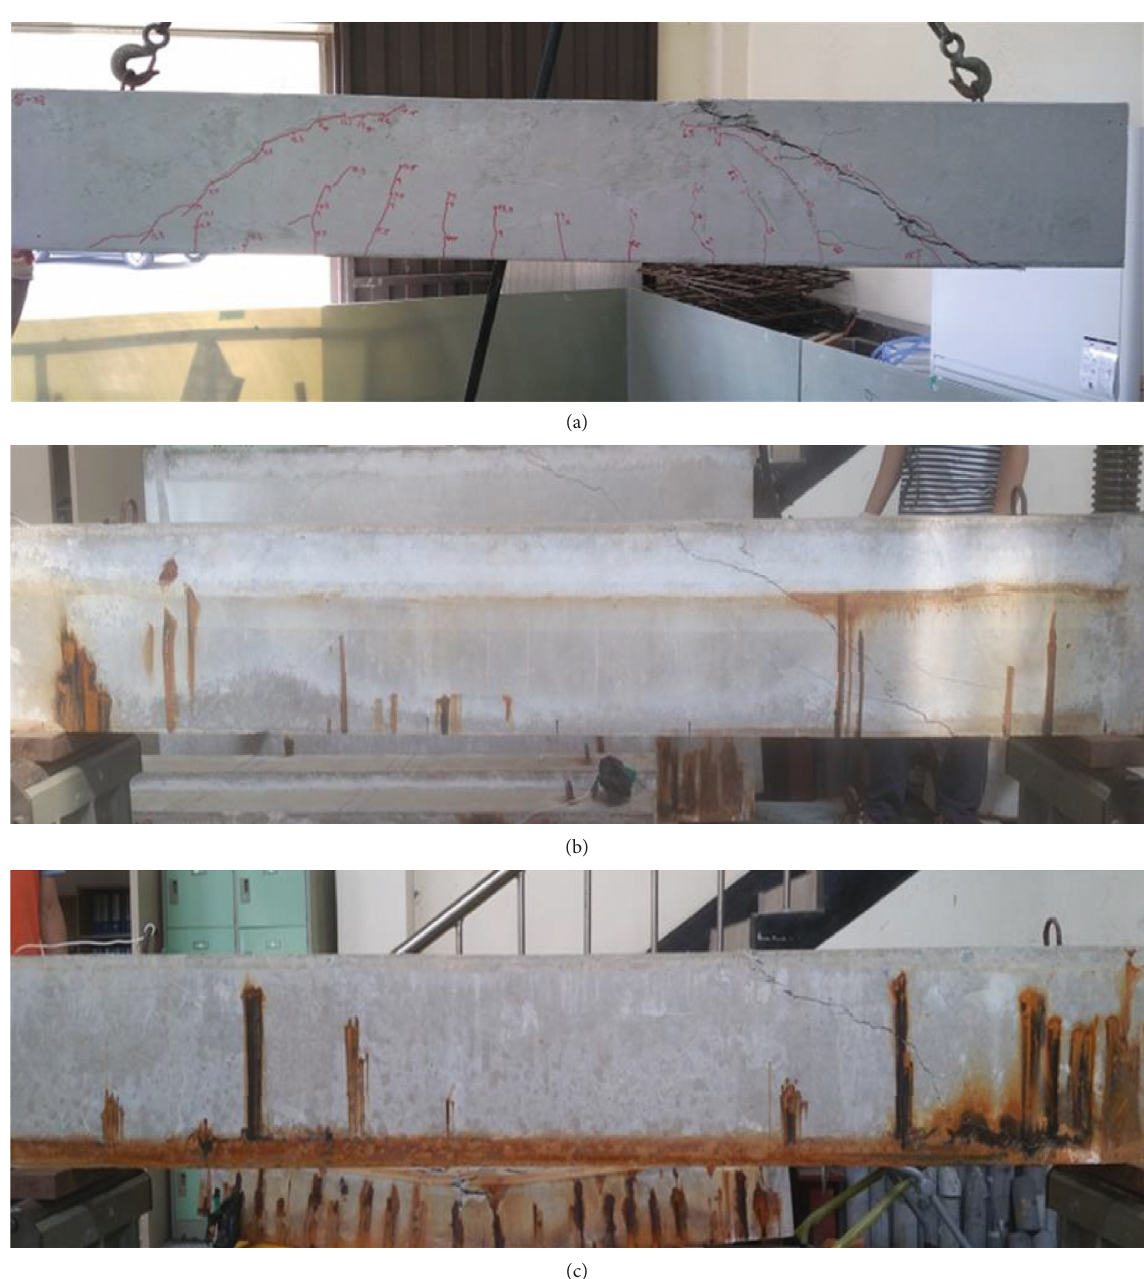
Figure 11: Cracking and failure patterns of shear failure type beams: (a) SB-C0 beam, (b) SB-C4 beam, and (c) SB-C7